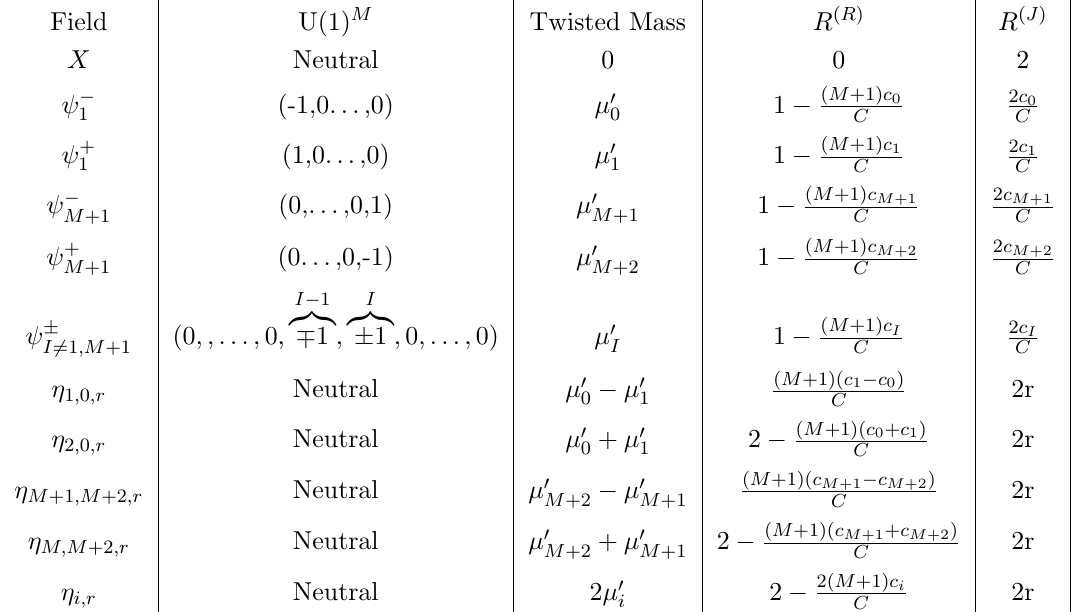
Table 4 . The spectrum on the worldsheet for strings described in